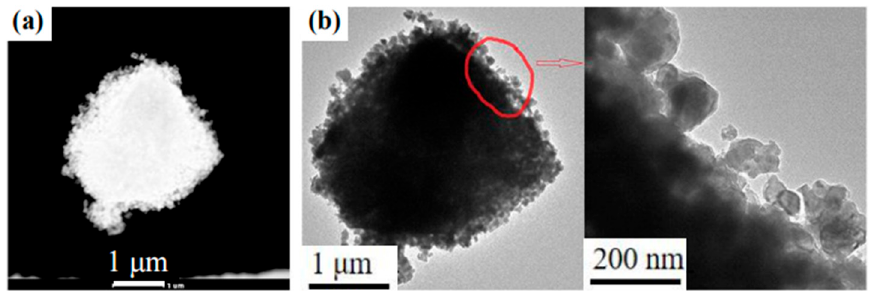
Figure 6. TEM images in ( a ) low magnification and ( b ) high magnification for the BST@ 10 wt% Fe 2 O 3 particle and the partially enlarged view of BST@ 10 wt% Fe 2 O 3 .